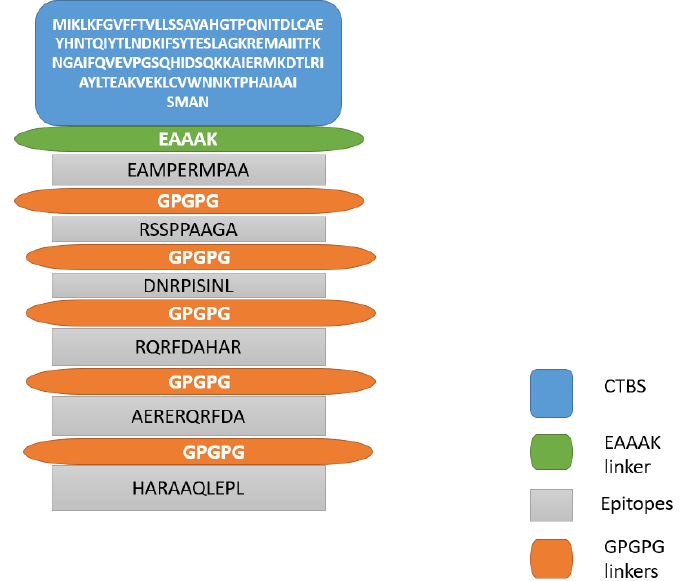
Figure 5. The 3D structure of multi-epitopes vaccine. Each segment is properly labeled in the fig- ure.